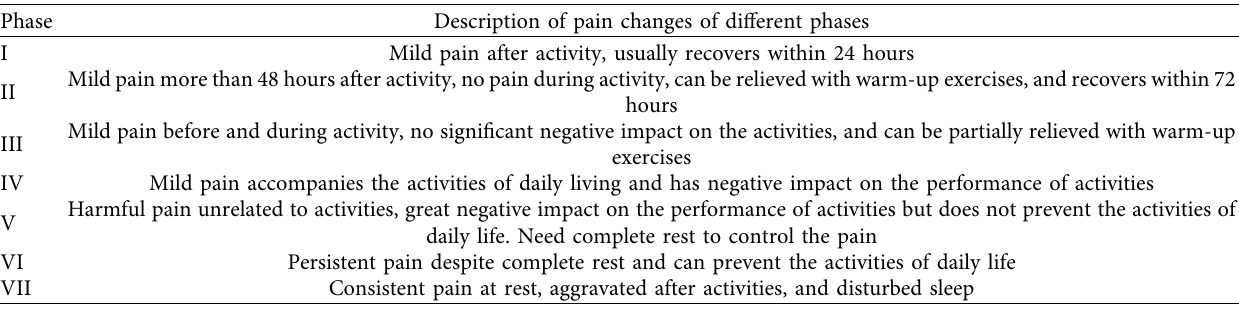
Table 2: Clinical classification of lateral epicondylitis